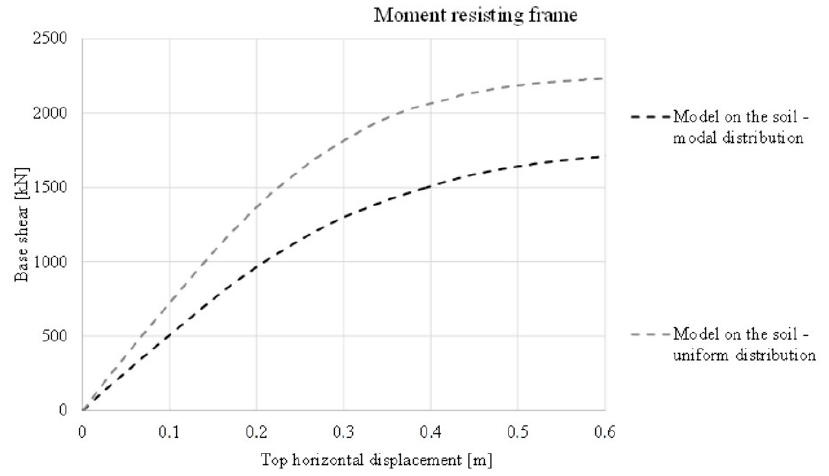
Figure 9. Numerically obtained results for the moment resisting